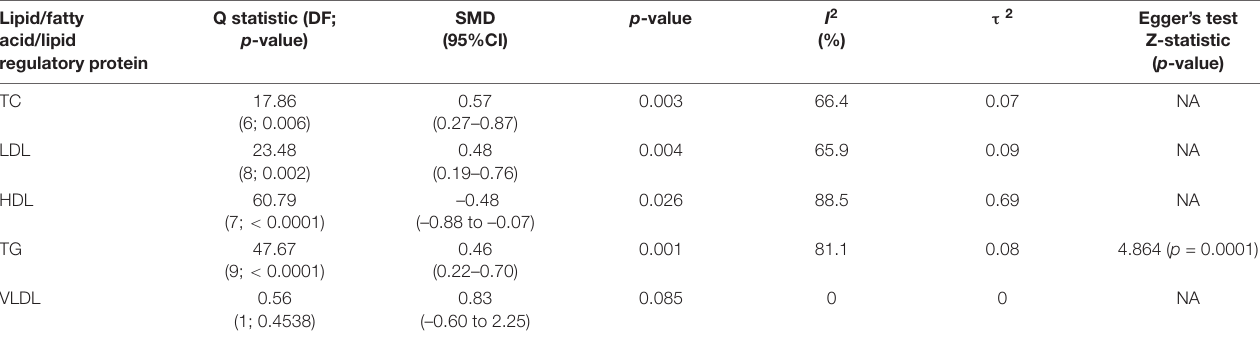
TABLE 4 | Meta-analysis of lipid levels in PTSD. Lipid/fatty acid/lipid regulatory protein